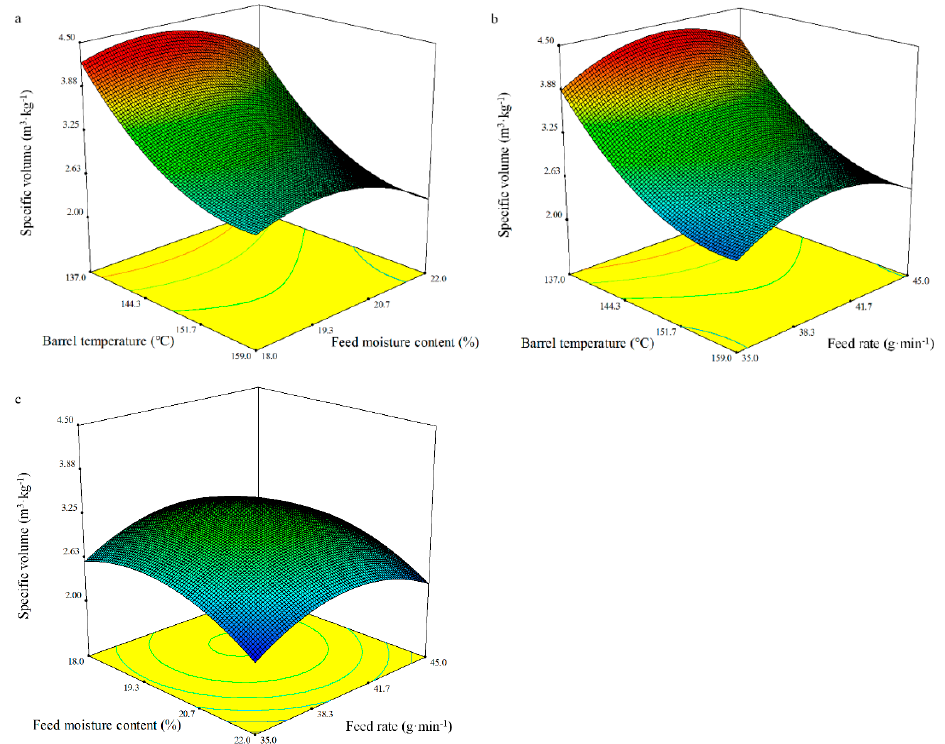
Figure 1. Response surface plot of a specific volume of the whole BGW extrudates.